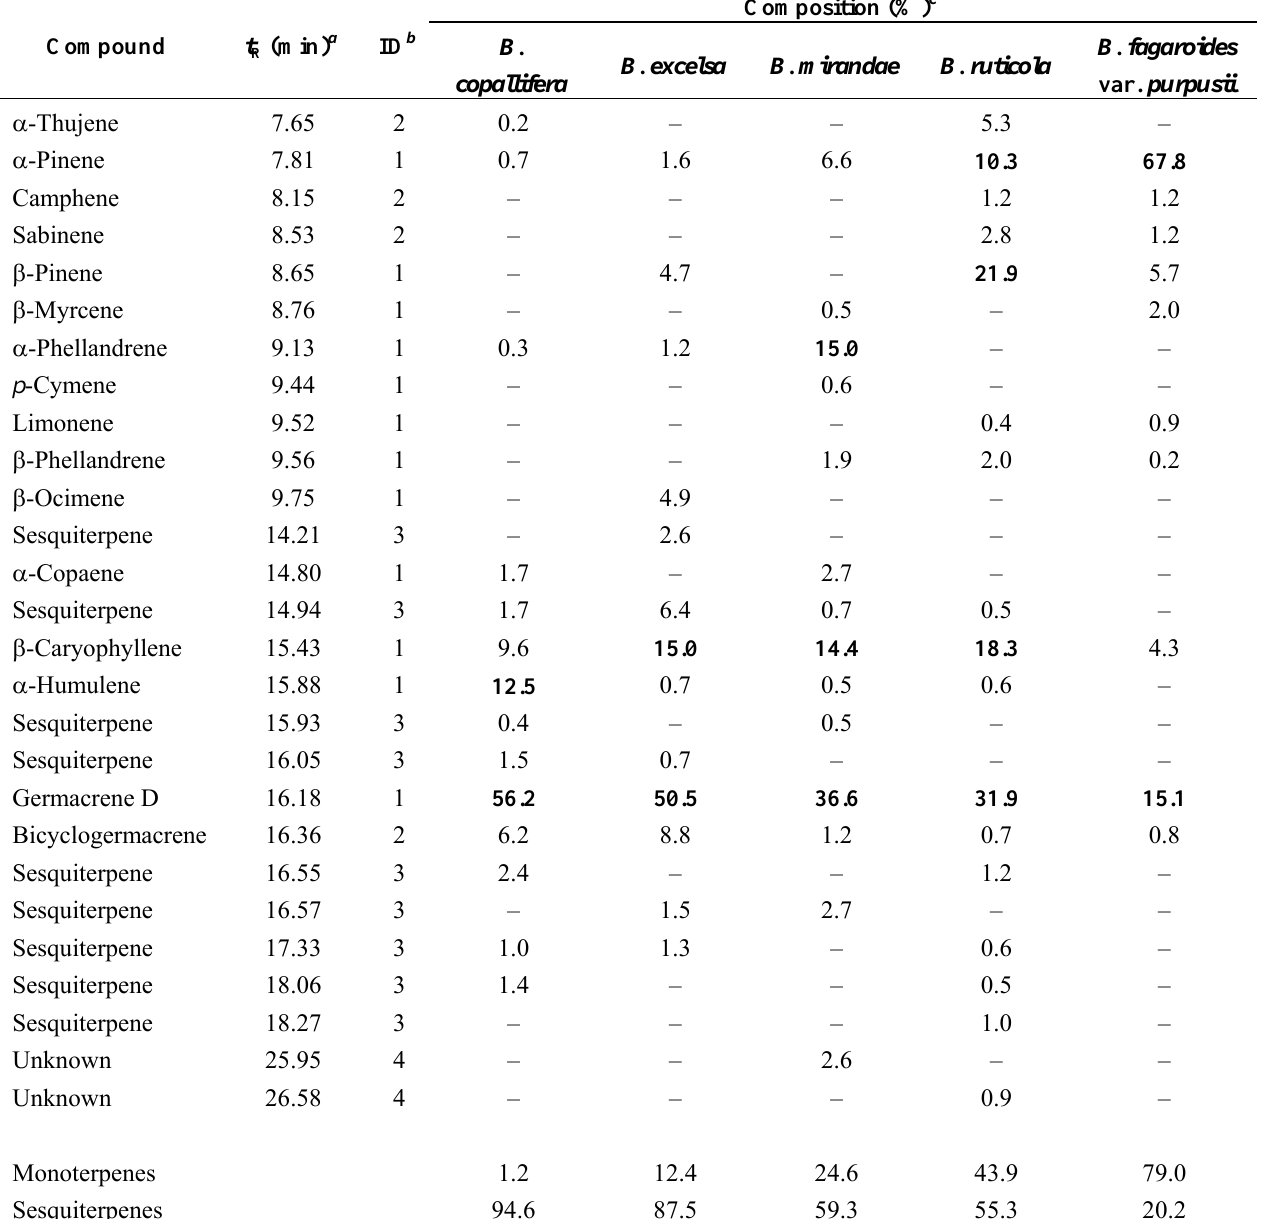
Table 1. Composition in the leaf of five Bursera